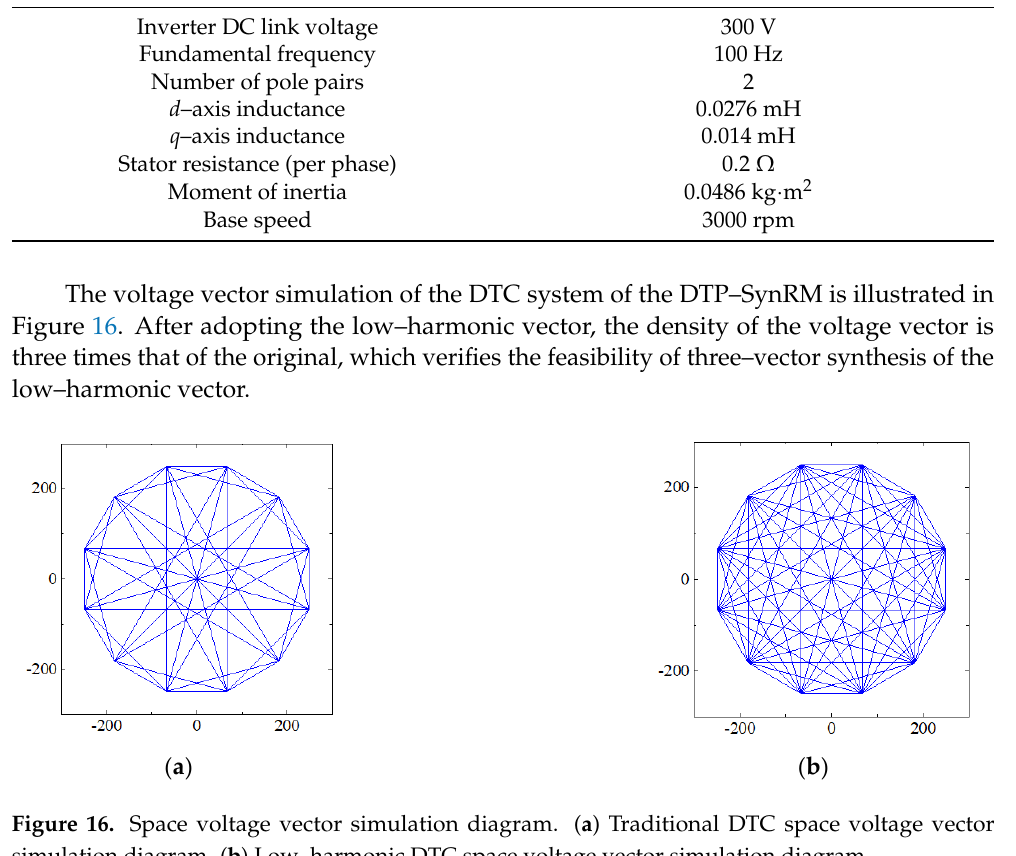
Table 4. Motor parameter table.